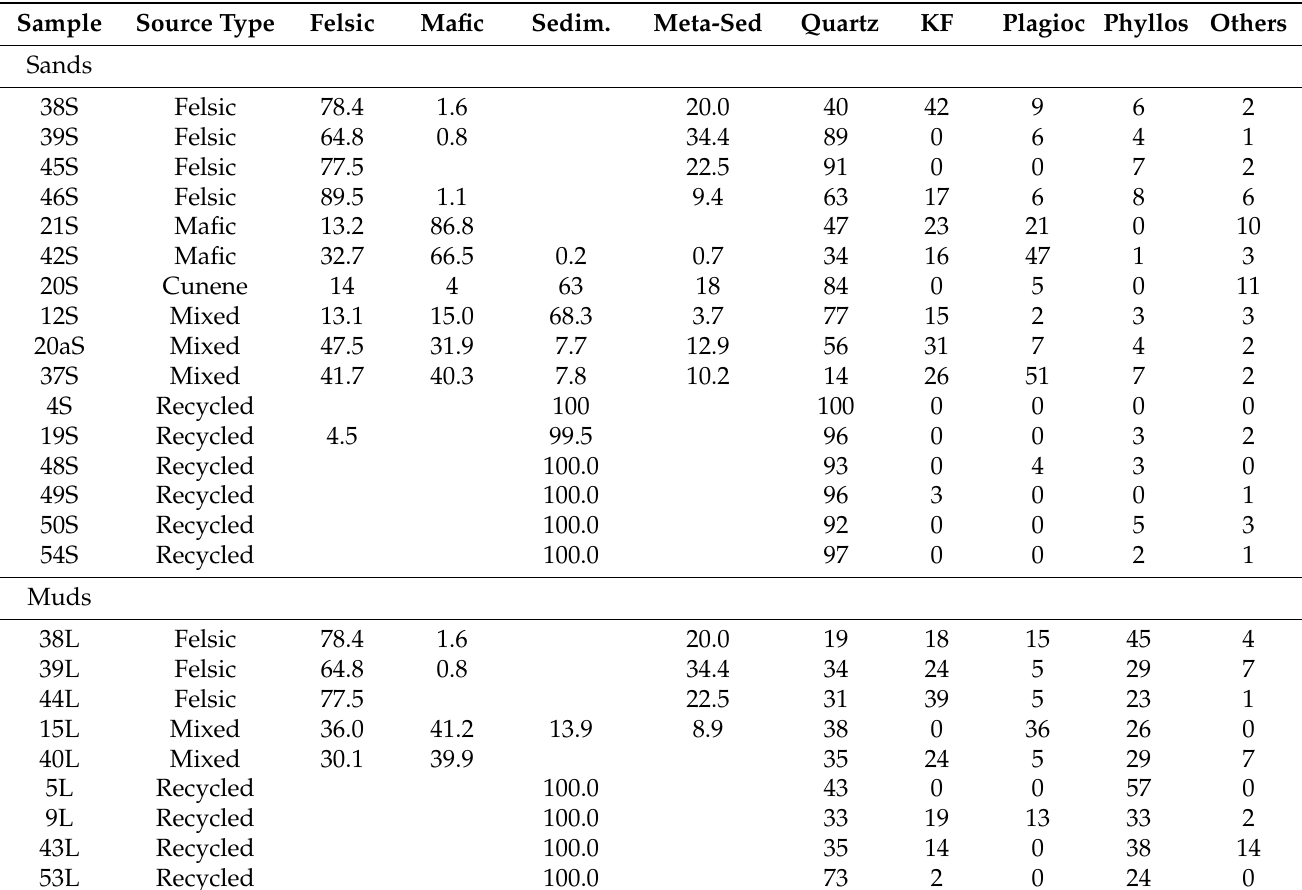
Table 1. Representation of different geological units in the catchment areas of the sampling points and overall XRD mineralogy obtained for each sediment sample (%